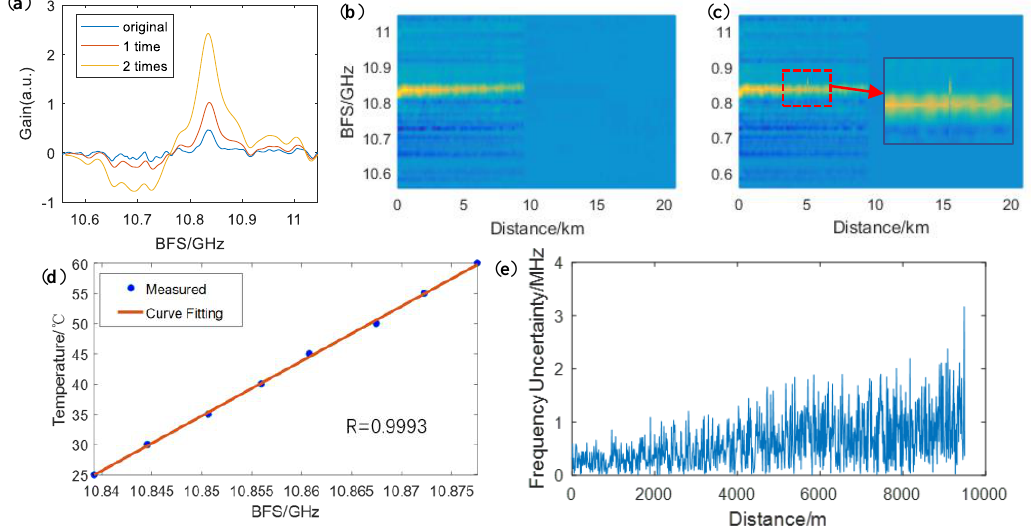
Figure 6. ( a ) Results of cross-correlation with Lorentz lineshape; ( b ) Brillouin gain spectrum (BGS) distribution in normal environment; ( c ) BGS distribution with a 10 m fiber section heating; ( d ) temperature-BFS measurement results; ( e ) frequency uncertainty over the fiber link.